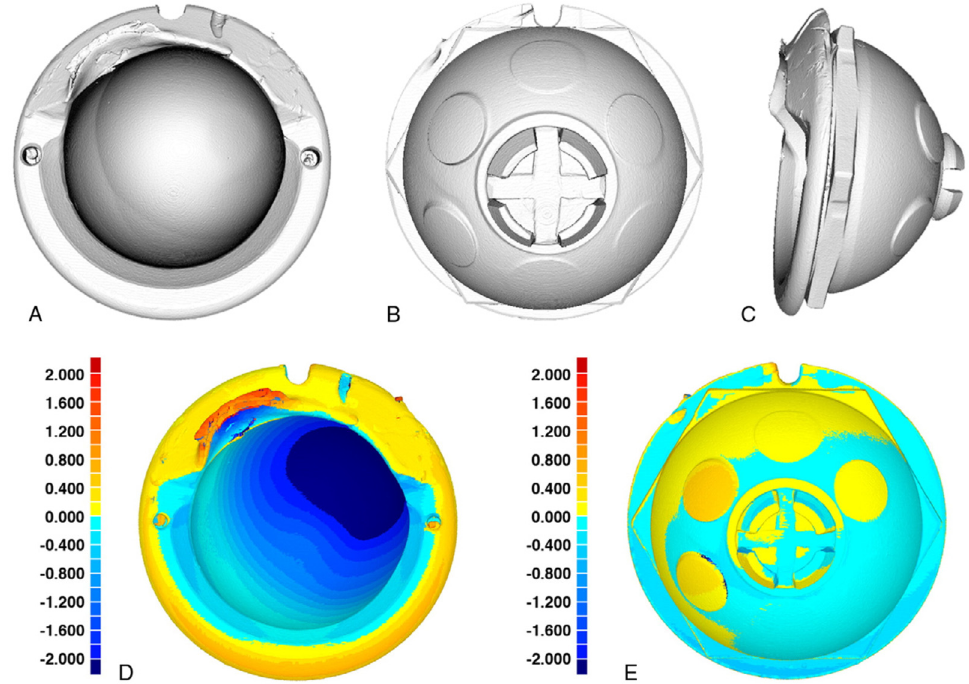
Figure 7. Three-dimensional rendered volume images of the retrieved acetabular liner scanned using micro-CT (( A ) frontside view, ( B ) backside view, ( C ) isometric view) and 3D surface deviation maps in millimeters (( D ) frontside view, ( E ) backside view). The liner has been oriented as it was in vivo, with the lip in the superior direction, Reprinted with permission from ref. [200], Elsevier.